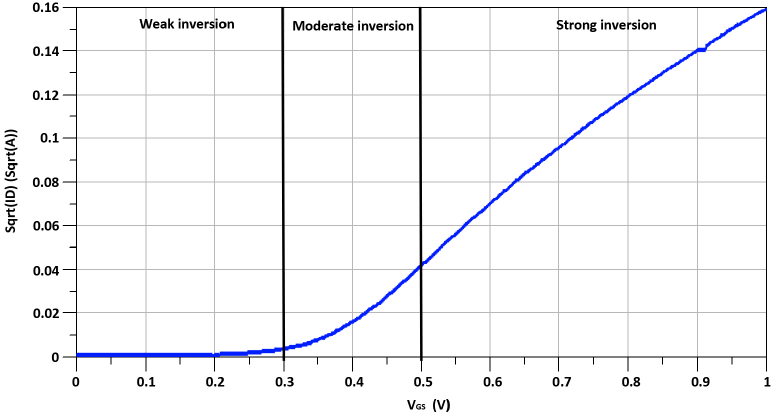
Figure 6. I–V DC characteristic curve of the transistors with drain current Ln(ID) on the vertical-axis.